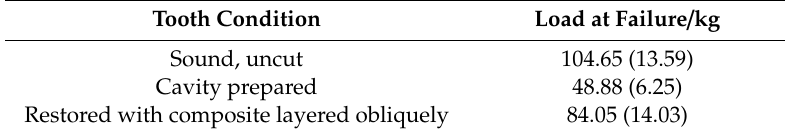
Table 2. Load at failure of human teeth ( n = 10) (standard deviations in